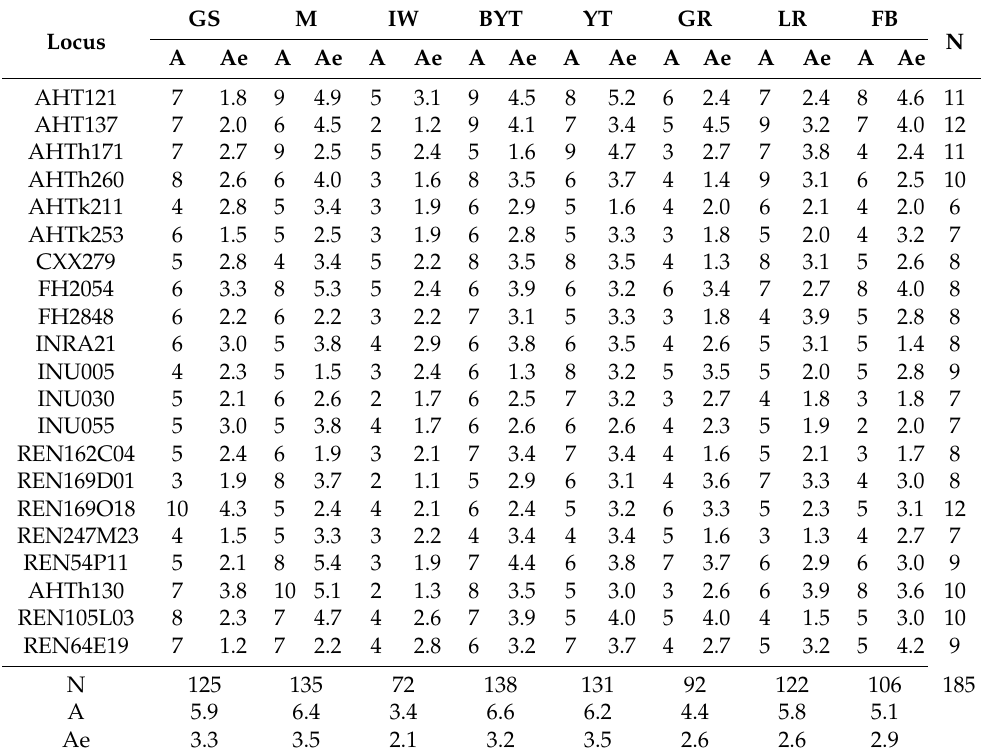
Table 2. The number of alleles identified per locus (N), mean number of alleles per locus (A), and mean effective number of alleles per locus (Ae) for each